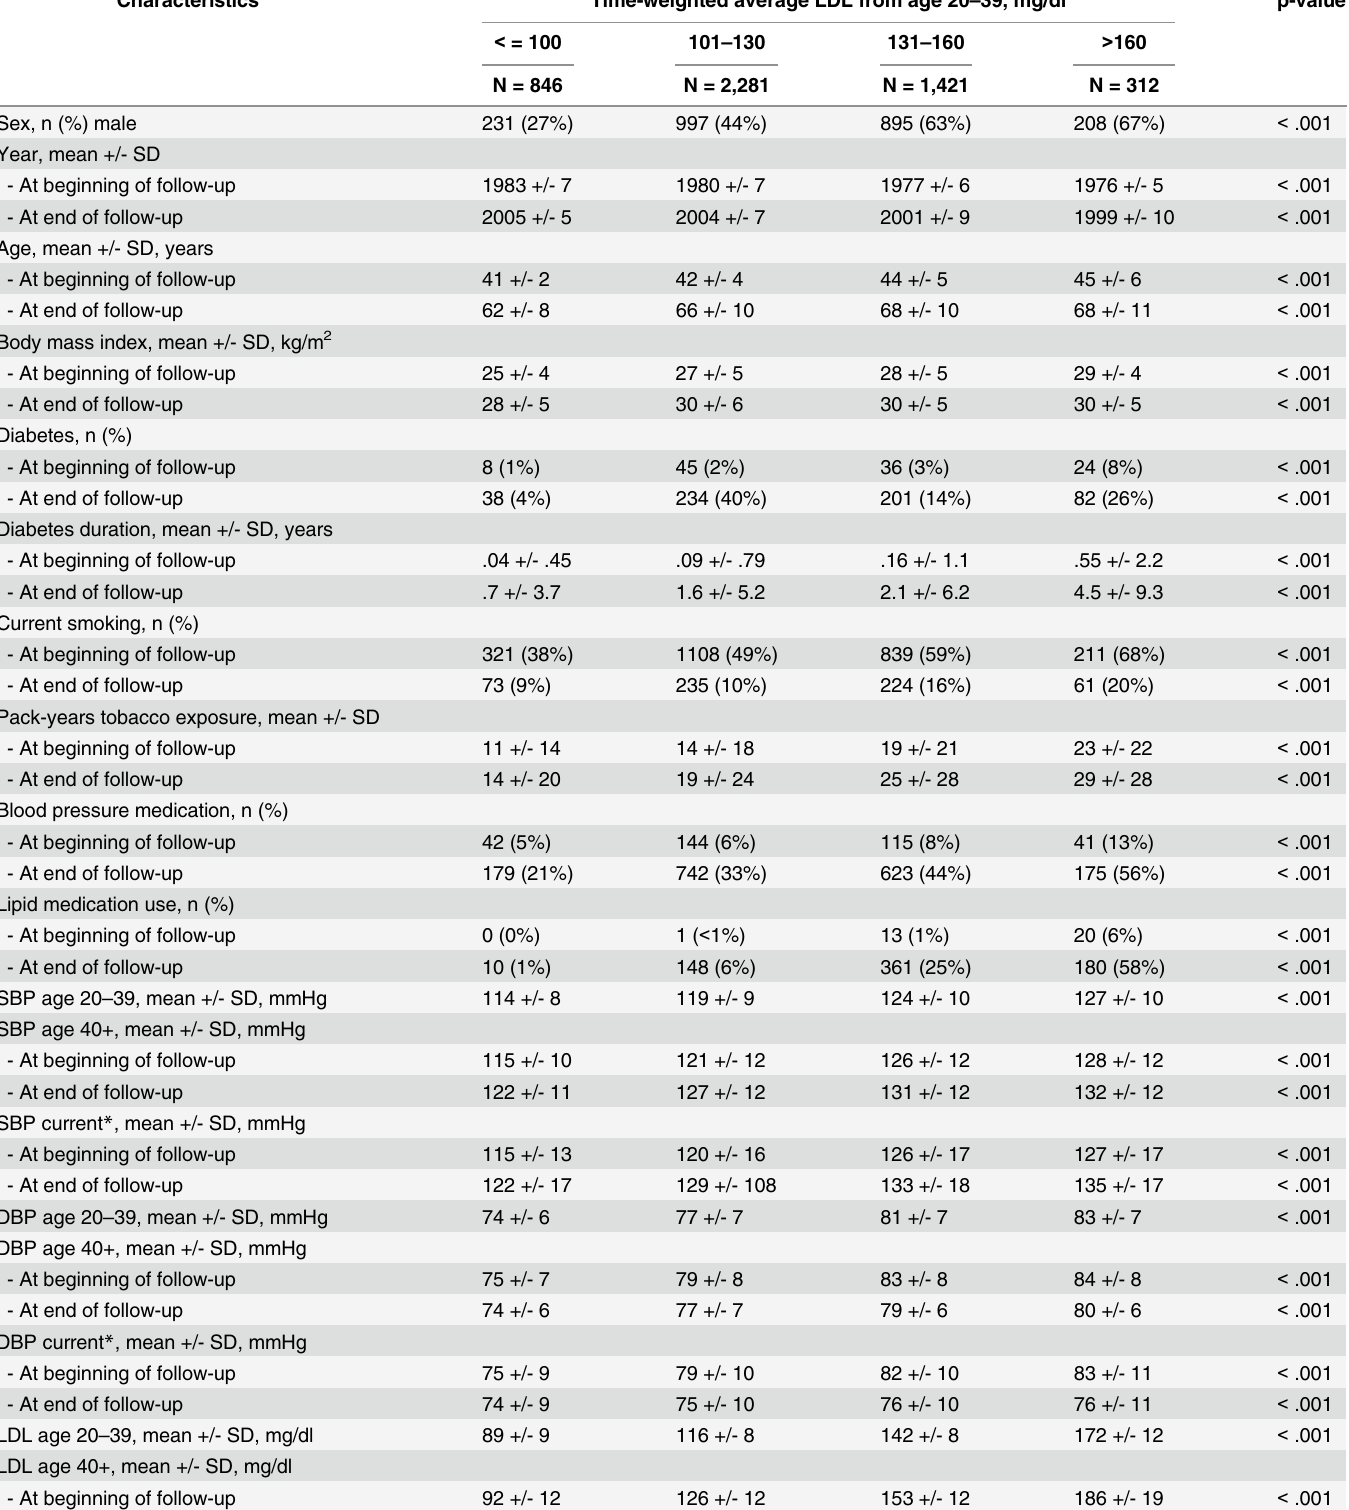
Table 2. Characteristics of participants at the beginning of follow up, stratified by early life exposure to LDL.